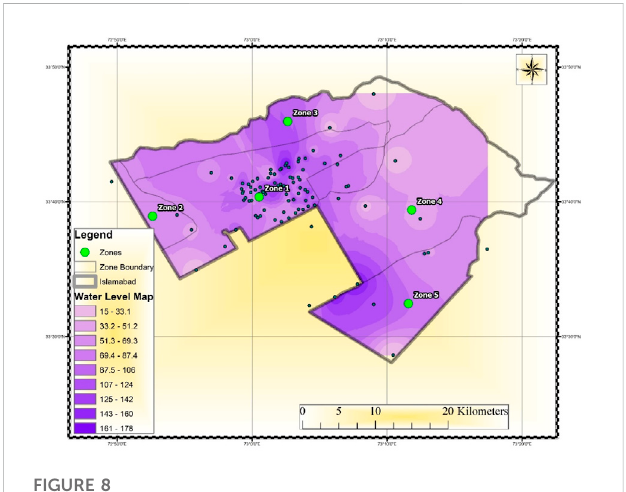
FIGURE 8 Contour map for static water level (feet) using well points.